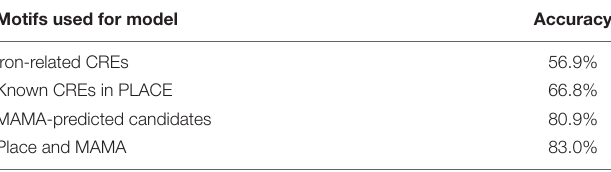
TABLE 1 | Accuracy of the gene expression pattern simulation model.